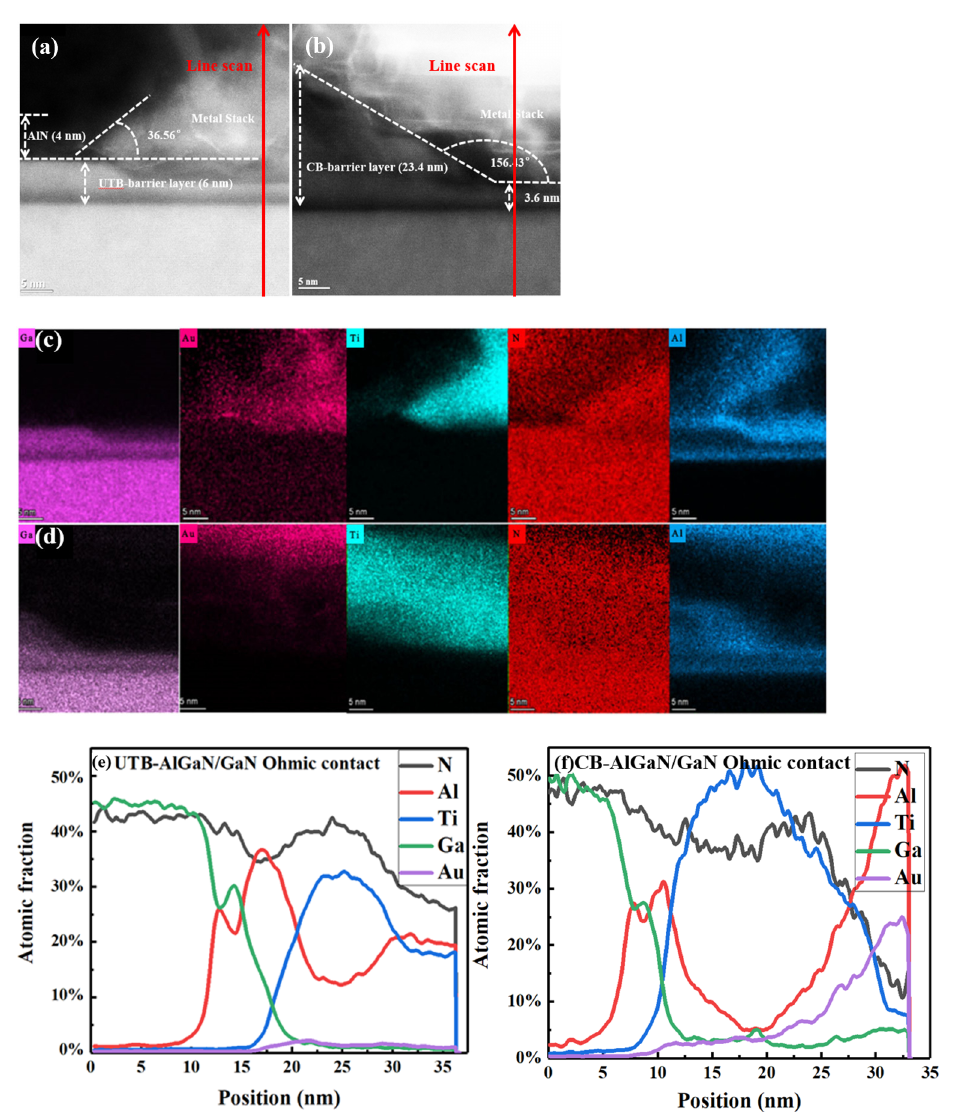
Figure 4. TEM cross − sectional view on ( a ) UTB and ( b ) CB − AlGaN/GaN heterostructure; EDS mapping of the ohmic contact on ( c ) UTB and ( d ) CB − AlGaN/GaN heterostructure; Line scan of the ohmic contact on ( e ) UTB and ( f ) CB − AlGaN/GaN heterostructure.